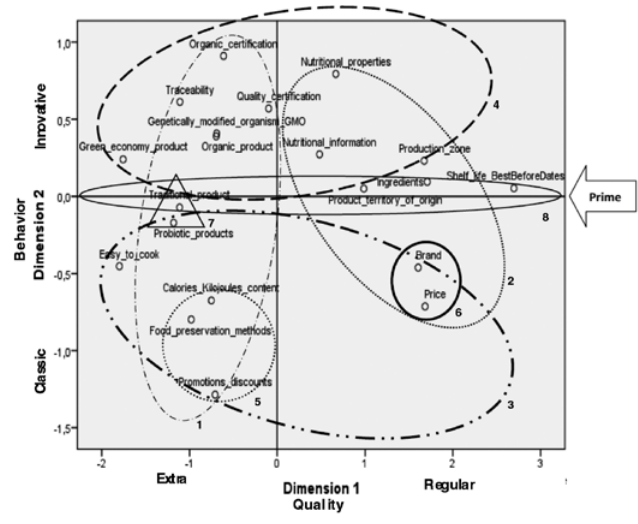
Fig. 1 - Preference classification of food attributes based on respon- dents’